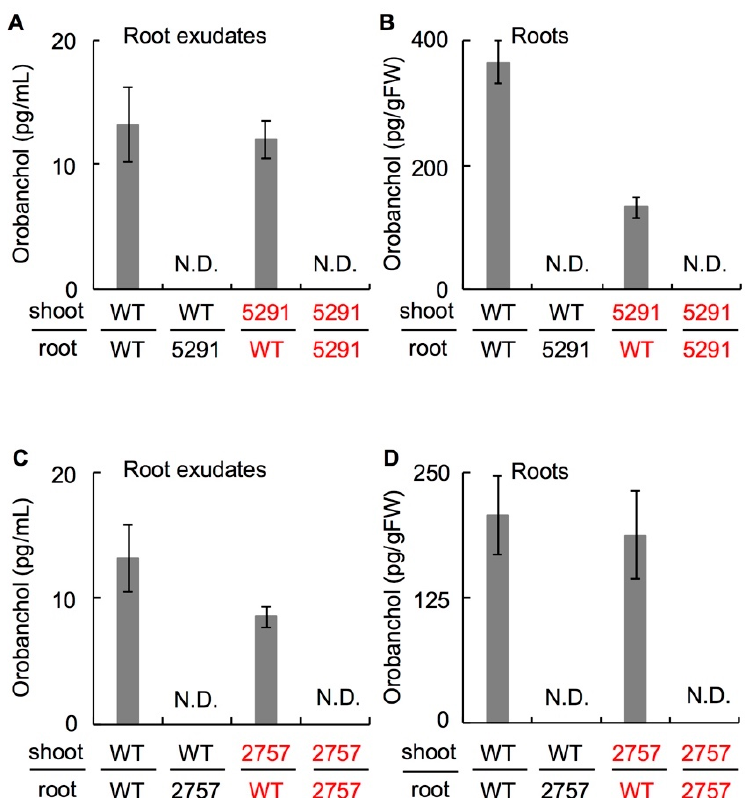
Figure 6. Orobanchol levels in root exudates and roots in different grafting combinations, between WT and slccd8 mutants. ( A ) n = 4–9. ( B ) n = 4–6. ( C ) n = 11–18. ( D ) n = 6–8. Error bars, S.E.; N.D., not detected.